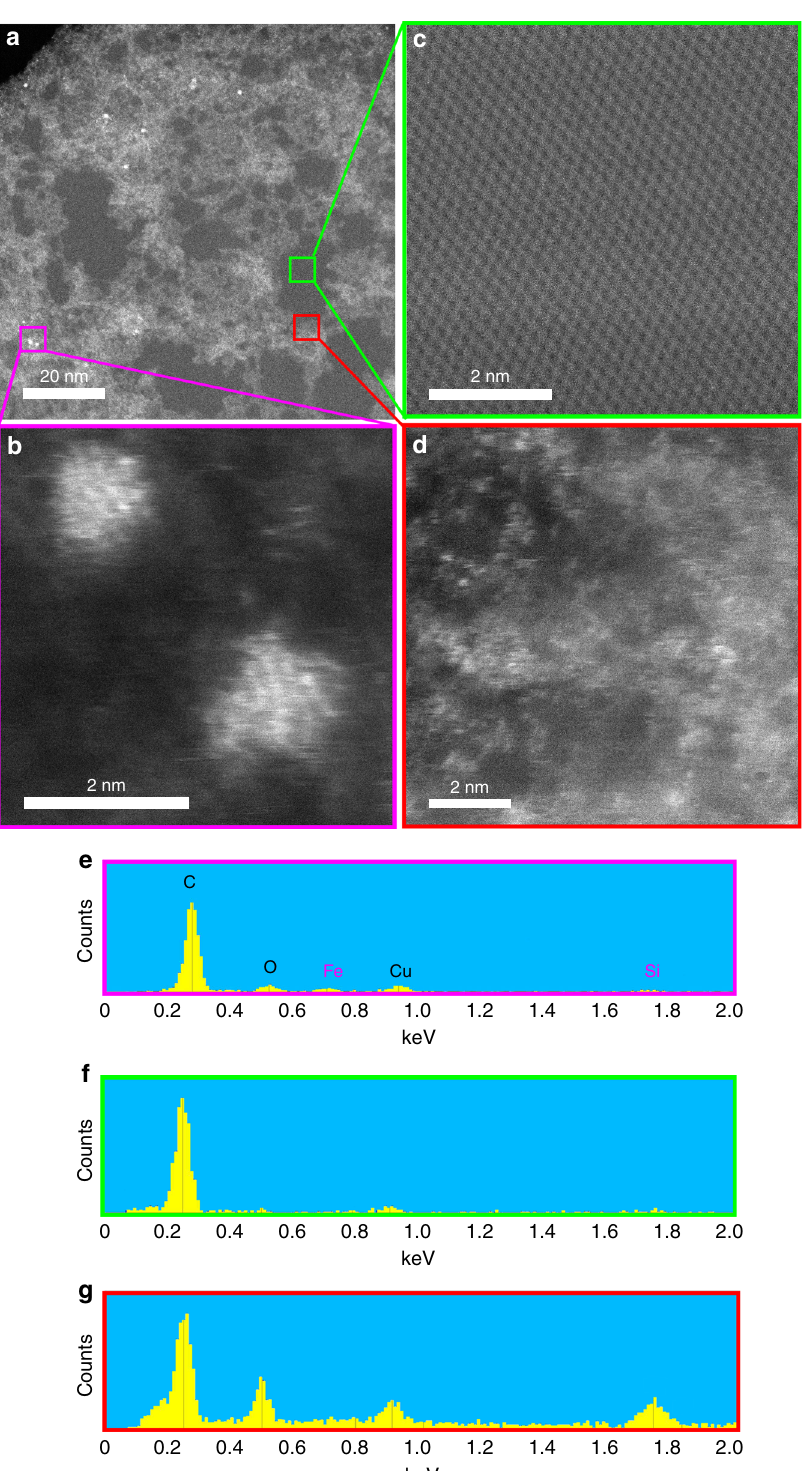
Fig. 4 The extent of silicon contamination on the surface of typical low purity graphite (98% purity). a HAADF image of a typical graphite platelet. Details of the various boxed regions in a showing: b an iron contamination, c a clean area with a perfect graphitic lattice structure, and d a silicon contaminated area. e – g EDS spectra of b – d , respectively, showing iron contamination, clean graphene and silica contamination,